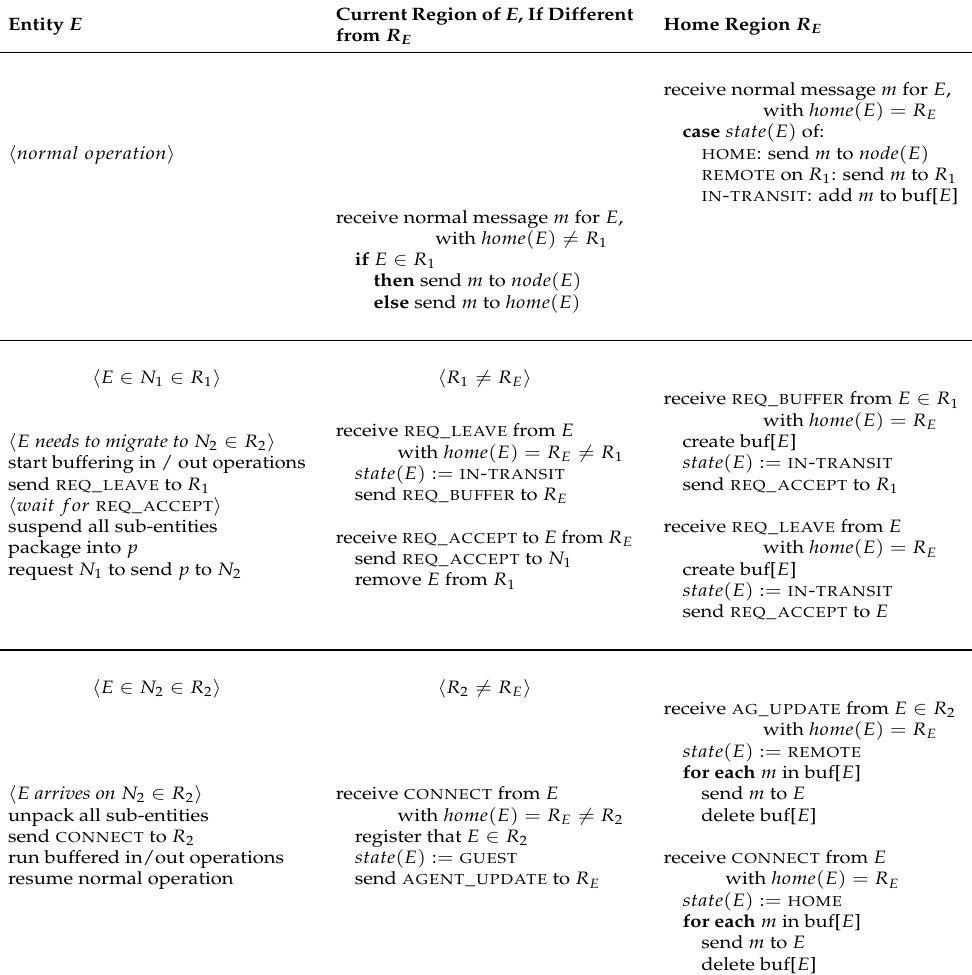
Table 3. Pseudocode for communication and migration-related processes in the WS-Regions